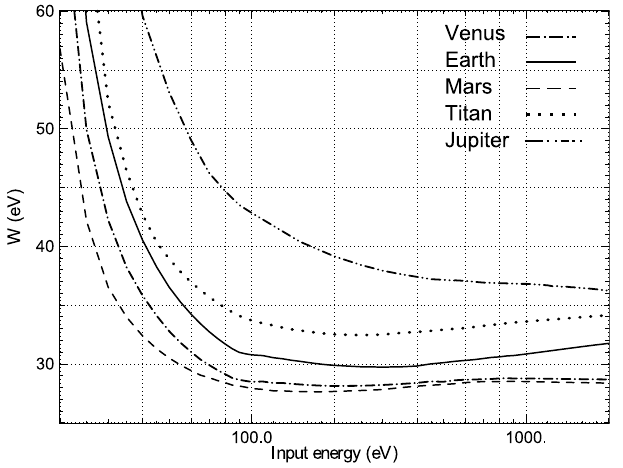
Fig. 1. Mean energy per electron-ion pair W net for Earth, Venus, Mars, Titan and Jupiter.